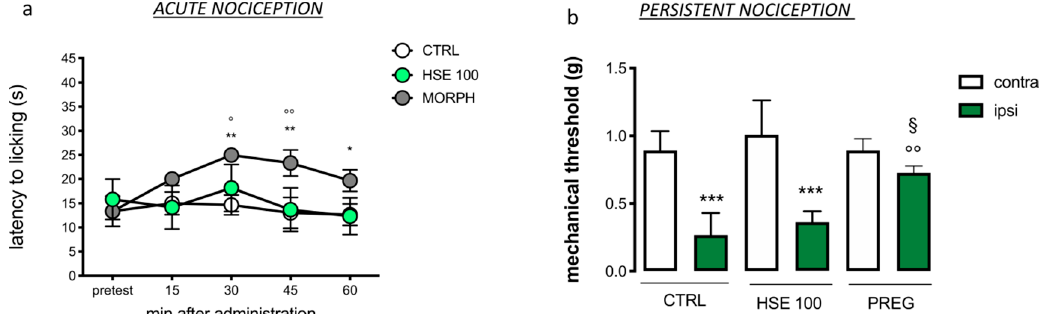
Figure 3. Antinociceptive profile of Helichrysum stoechas Moench methanolic extract (HSE) against an ( a ) acute thermal stimulus (hot plate test) in comparison with control group (CTRL) and morphine (MORPH) ( a , two-way ANOVA post-hoc Sidak, F(4,75) = 6.753, ** p < 0.01 * p < 0.05 vs. CTRL; °° p < 0.01, ° p < 0.05 vs. HSE 100) and against ( b ) mechanical stimulus (von Frey hairs) in a spared nerve injury (SNI) model ( b ; two-way ANOVA post-hoc Sidak, F (5,30) = 26.59, *** p < 0.001 vs. contra; °° p < 0.01 vs. HSE 100 ipsi; § p < 0.05 vs. CTRL). The vertical bars represent ± SD ( n = 6).